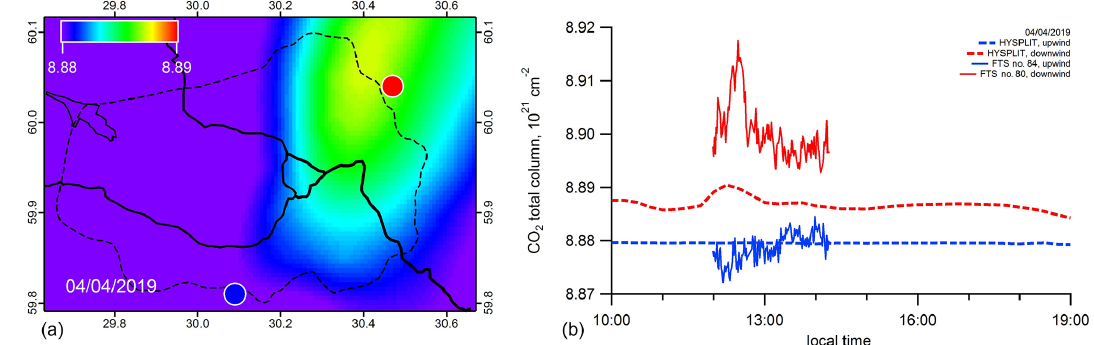
Figure 5. (a) Urban pollution CO 2 plume over St Petersburg calculated by the HYSPLIT model for 4 April 2019 (10:00UTC). The colour bar designates the CO 2 total column in units 10 21 cm − 2 . The blue and red circles indicate the locations of upwind and downwind FTS observations, accordingly. (b) Time series of measured (FTS) and simulated (HYSPLIT, without scaling of the ODIAC emissions data) CO 2 total column at the upwind (blue lines) and downwind (red lines) locations for the same day.